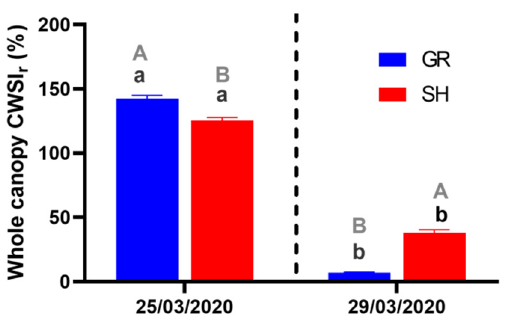
Figure 5. Ratios between the whole canopy CWSI of water-stressed and well-watered Grenache and Shiraz (CWSI r ) during WS (25/03/2020) and after recovery (29/03/2020). Each data point is the mean + standard error of the mean of three replicates. Different small black letters indicate statistically significant difference at p ≤ 0.05 over time within the same variety. Different capital grey letters indicate significant difference between varieties within the same date. Means were separated by unpaired two-tailed t -test using Tukey’s least significant difference (LSD) test.